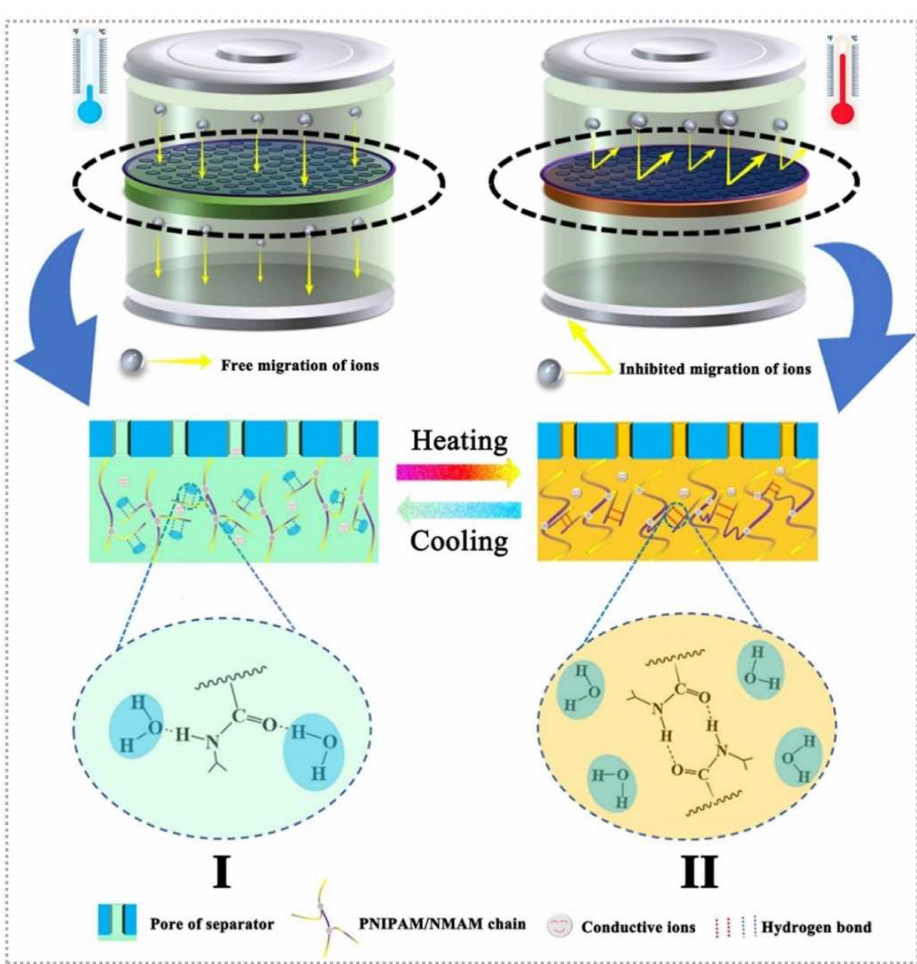
Figure 9. Schematic illustration of the self-protection/thermal-switching function enabled by PNIAPM-co-NMAM polyelectrolytes in the energy storage devices. Thermal-responsive self- protection mechanism of the PNIAPM-co-NMAM polyelectrolyte at low temperature (I) and high temperature (HT) (II). Reprinted with permission from Ref. [64]. Copyright 2021 ACS